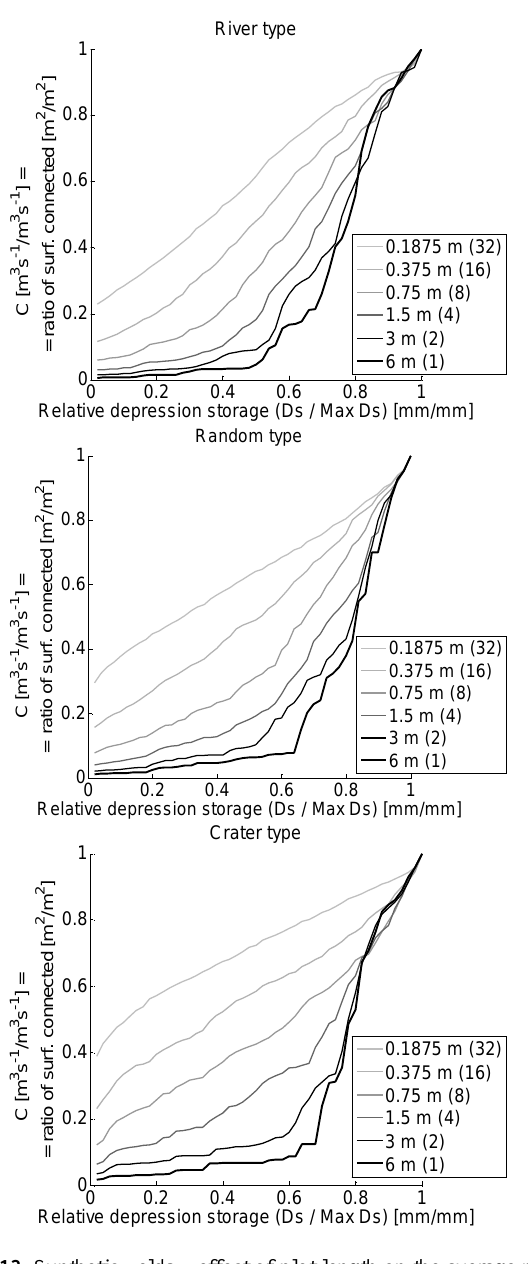
Fig. 13. Synthetic fields – effect of plot length on the average nor- malized RSC function for the river, random and crater type micro- topographies. Depression storage (x-axis) was scaled by the maxi- mum depression storage. The numbers in parentheses indicate the number of connectivity curves used for calculating the average nor- malized RSC functions. All plots are 6m wide.